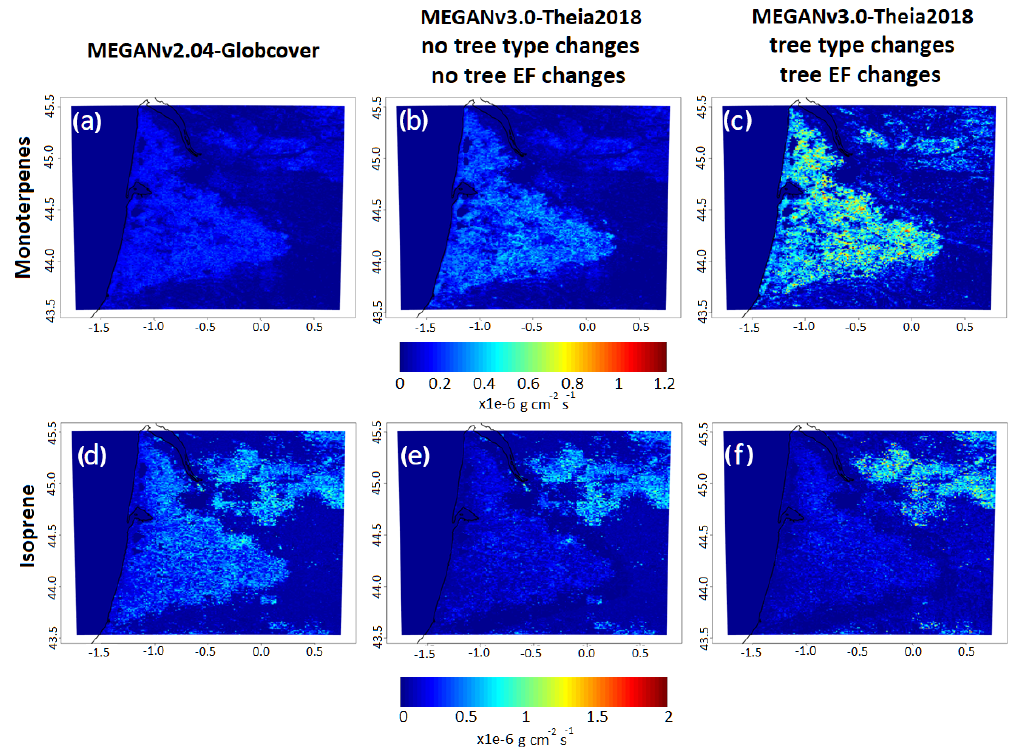
Figure 4. Changes to monoterpene (first row, a – c ) and isoprene (second row, d – f ) emissions in base case conditions (left column, a and d ), changing only the land cover (middle column, b and e ), and when both the land cover and MEGAN version are updated (right column, c and f ). For each species one scale is provided under the three panels; keep in mind both scales should be multiplied by 1 × 10 − 6 (the unit for all panels is gcm − 1 s − 1